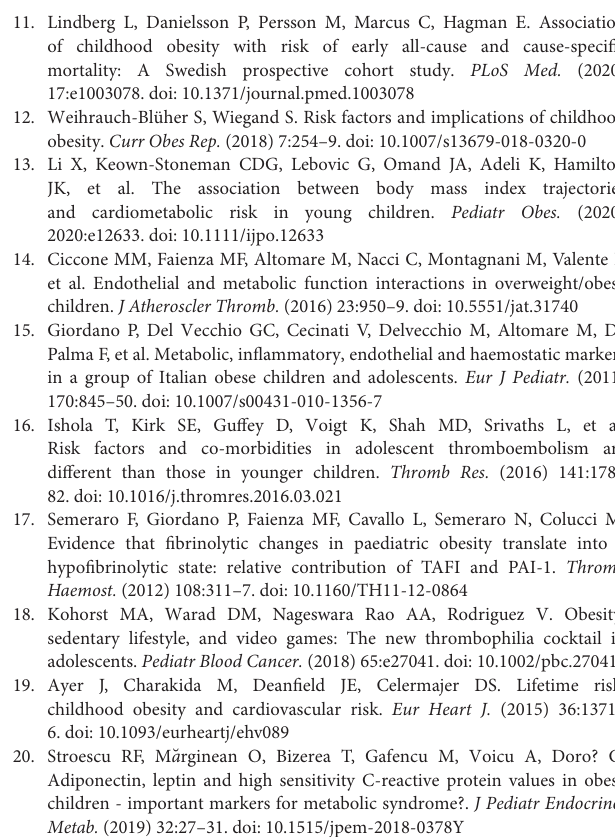
Supplementary Figure 1 | Childhood obesity causes adult obesity, and metabolic and cardiovascular disease in childhood. In adults, the risk of cardiovascular disease is affected by obesity and cardiovascular disease in childhood. On the other hand, the risk of metabolic disorders is affected by obesity and metabolic disorders in childhood. Supplementary Table 1 | The table displays the etiology of childhood obesity. Modified by Aggarwal et al. (6). Supplementary Table 2 | The table summarizes the classification of metabolic syndrome at different age. DBP, diastolic blood pressure; MetS,